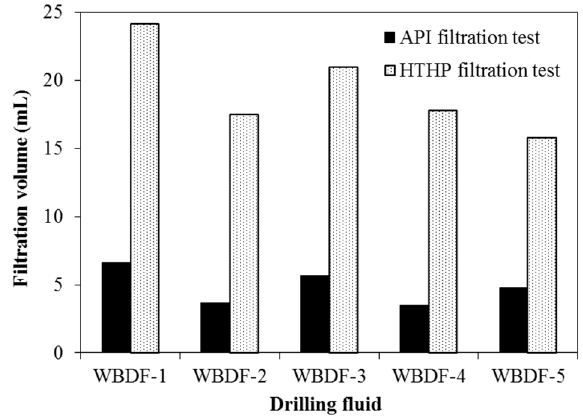
Figure 11. Filtration volumes with different WBDFs.